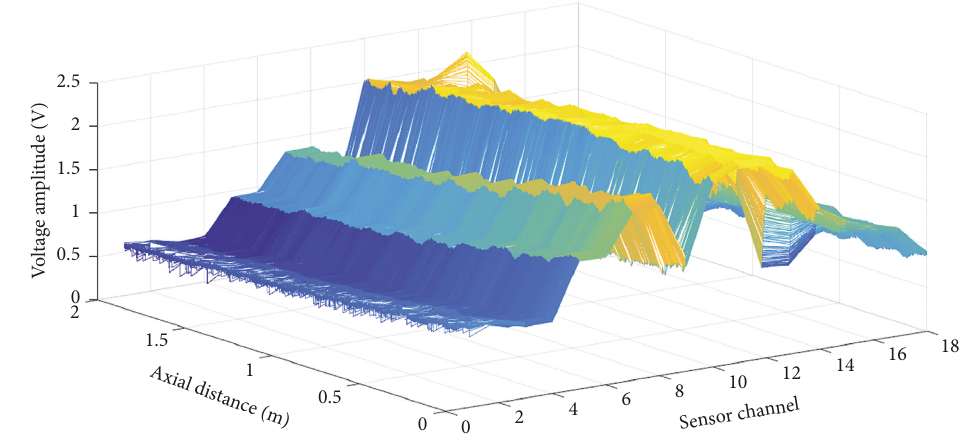
Figure 7: Expanded data of MFL signal.